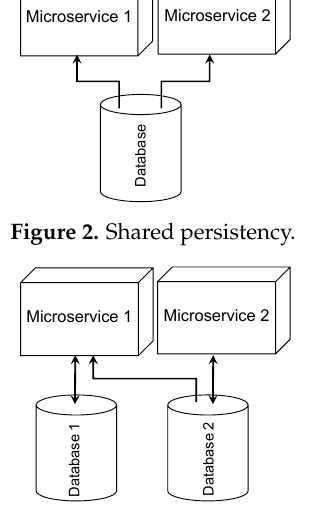
Figure 1. Example ESB usage.